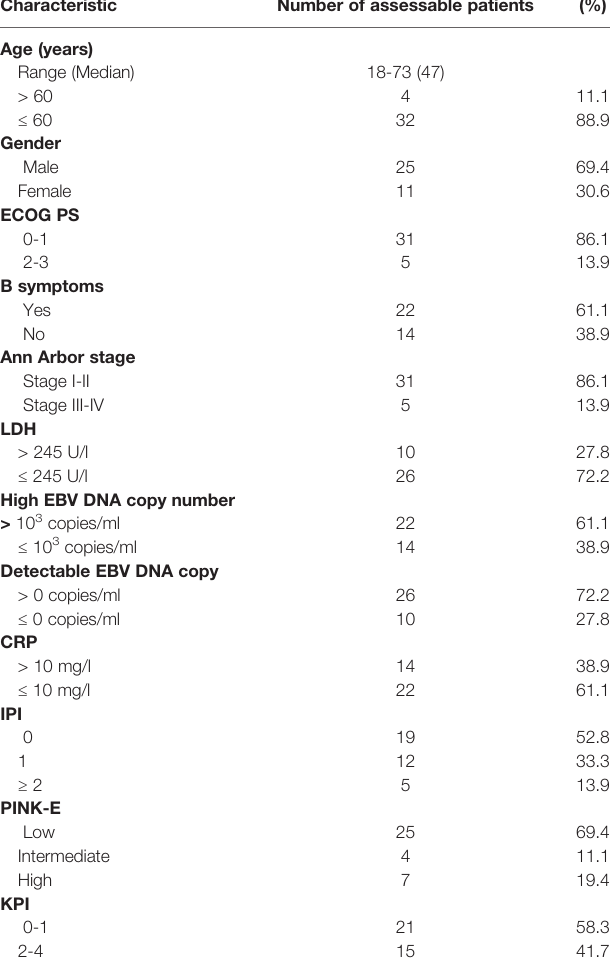
TABLE 1 | Baseline patient characteristics (n =